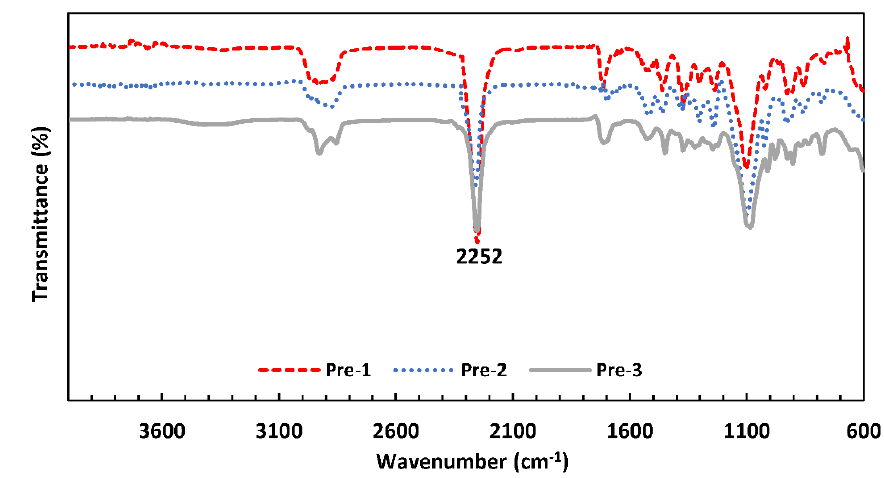
Figure 3. The FTIR spectra of the three polyurethane quasi-prepolymers.